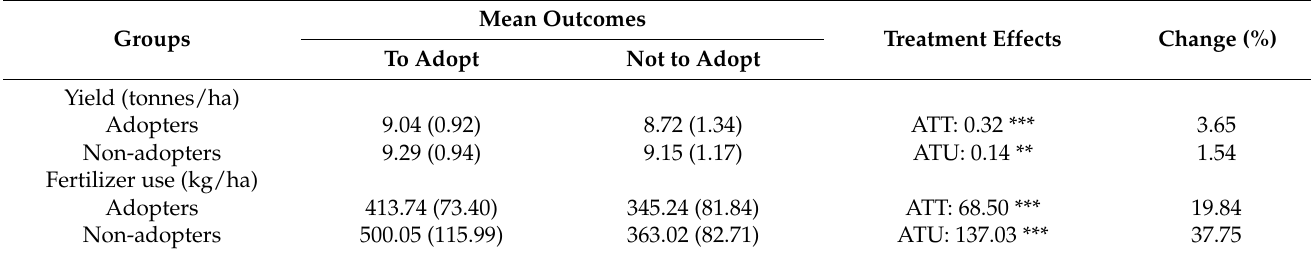
Table 5. Average treatment effects of the adoption of direct seeding in rice